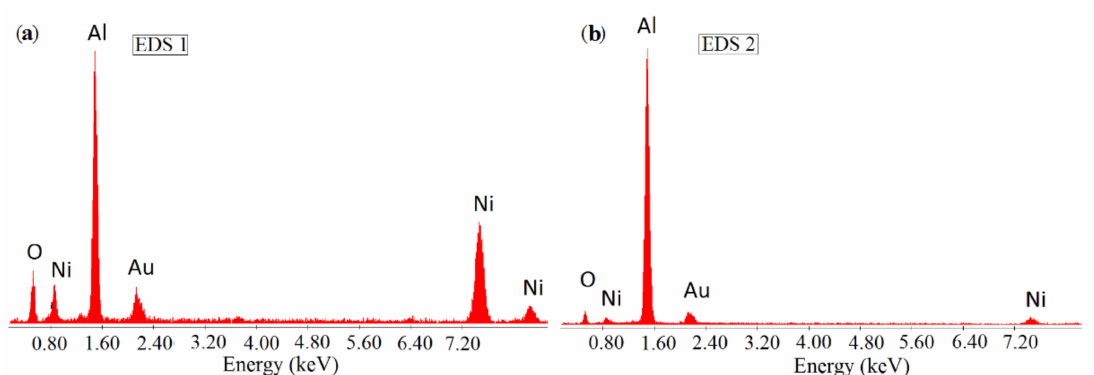
Figure 9. Chemical analysis of the 24.1% NiO—55.9% Al—20% Al 2 O 3 catalyst: ( a ) for the area (EDS 1); ( b ) for the point (EDS 2).